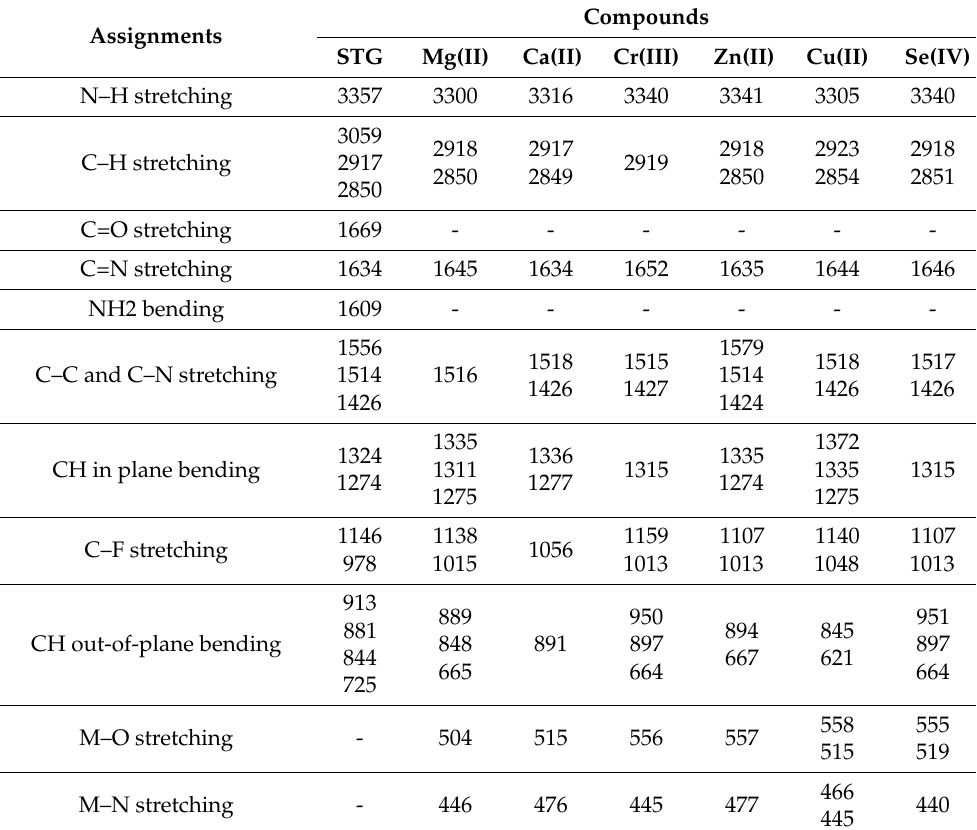
Table 2. Infrared spectral bands and assignments of STG and its